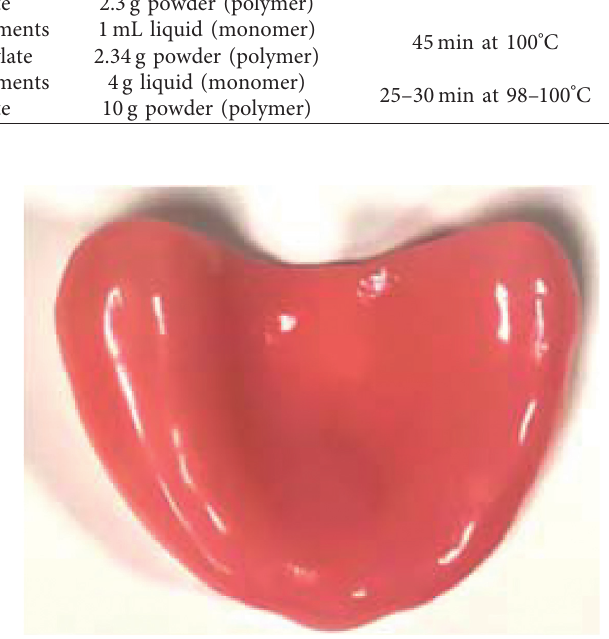
Figure 3: Example of an acrylic resins Megacryl ® sample.